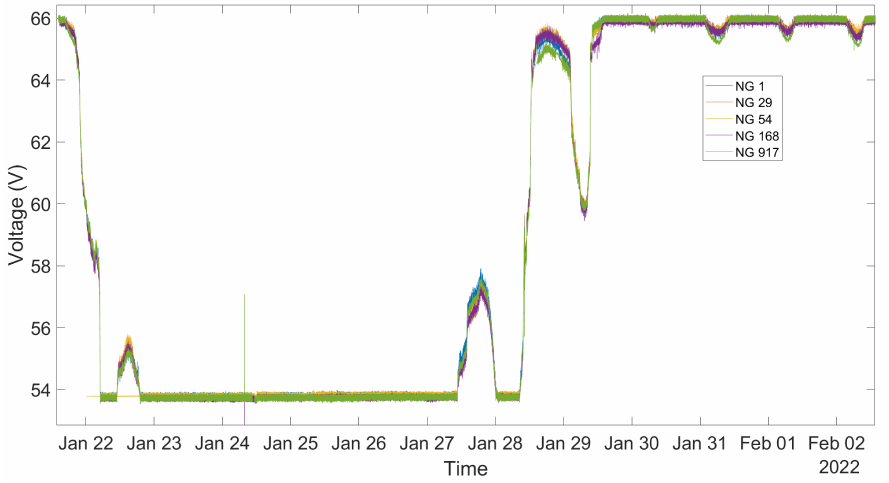
Figure 35. Evolution of the DC bus voltage on Ambohimena microgrid during a rainy